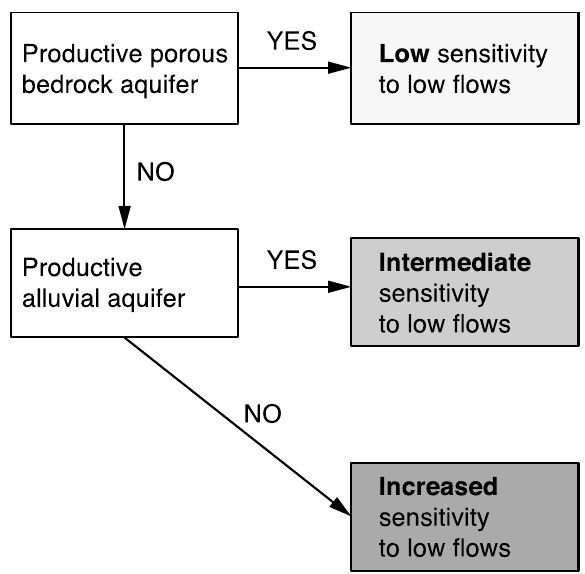
Figure 6. Decision tree illustrating in a generalized way the results of this study. If assessing the sensitivity of a catchment to low flows based on the geology, the presence of a productive porous bedrock aquifer and/or of productive alluvial aquifers is essential. If both are absent, the catchment is likely characterized by an increased sensitivity to low flows.